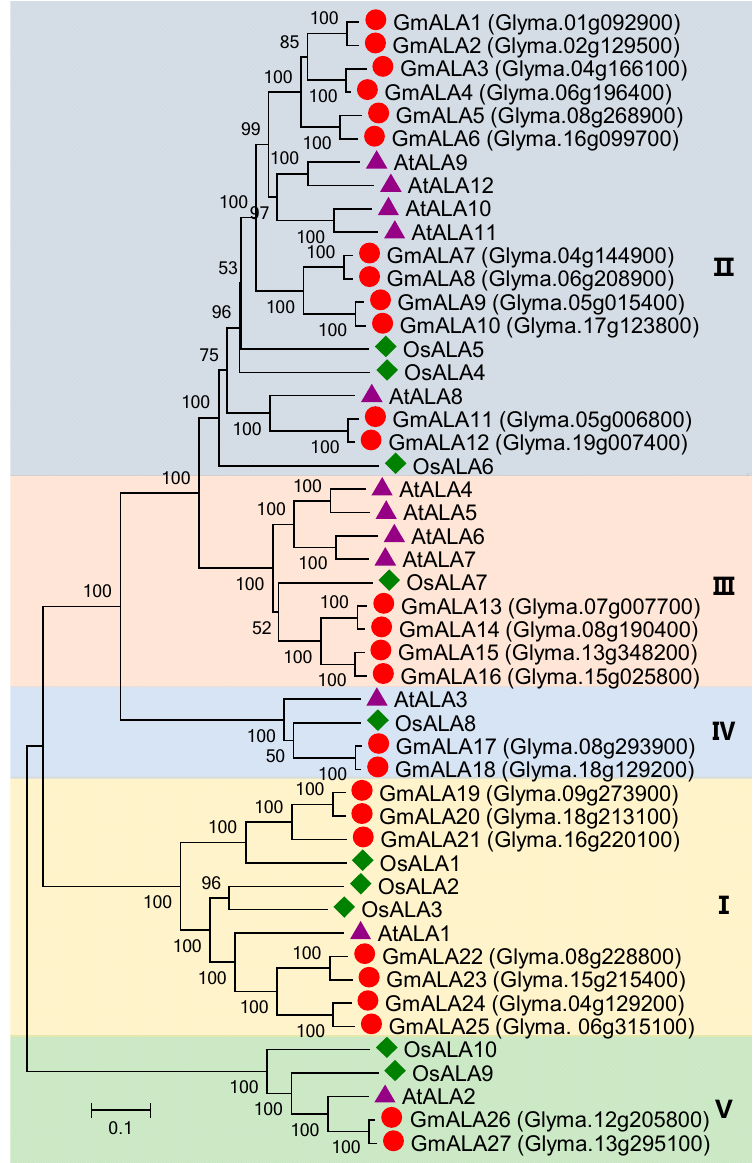
Figure 7. Phylogenetic tree of soybean ( Glycine max ), rice ( Oryza sativa ), and Arabidopsis thaliana of the P4 subfamily: the neighbor-joining phylogenetic tree was made using MEGA6 with 1000 bootstrap replications by aligning full-length amino acid sequences with ClustalW. GmALAs are denoted by red circles, AtALAs are denoted by purple triangles, while OsALAs are denoted by green diamonds. The locus name of the soybean gene is shown in brackets. Roman numerals designate the subfamilies.